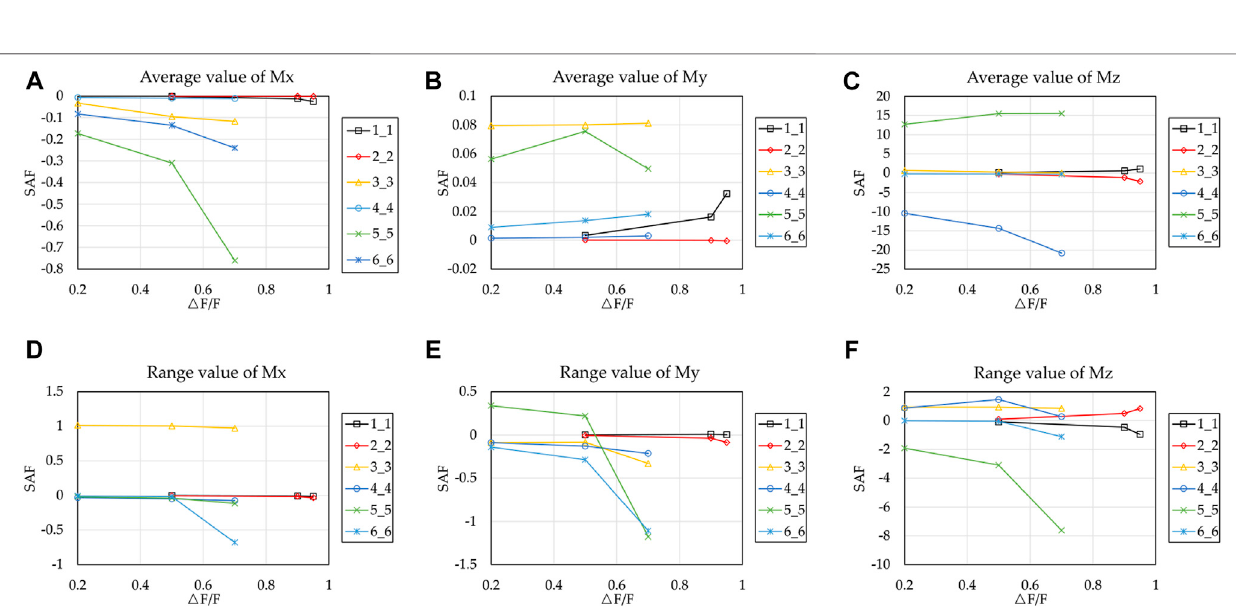
Frontiers in Energy Research |